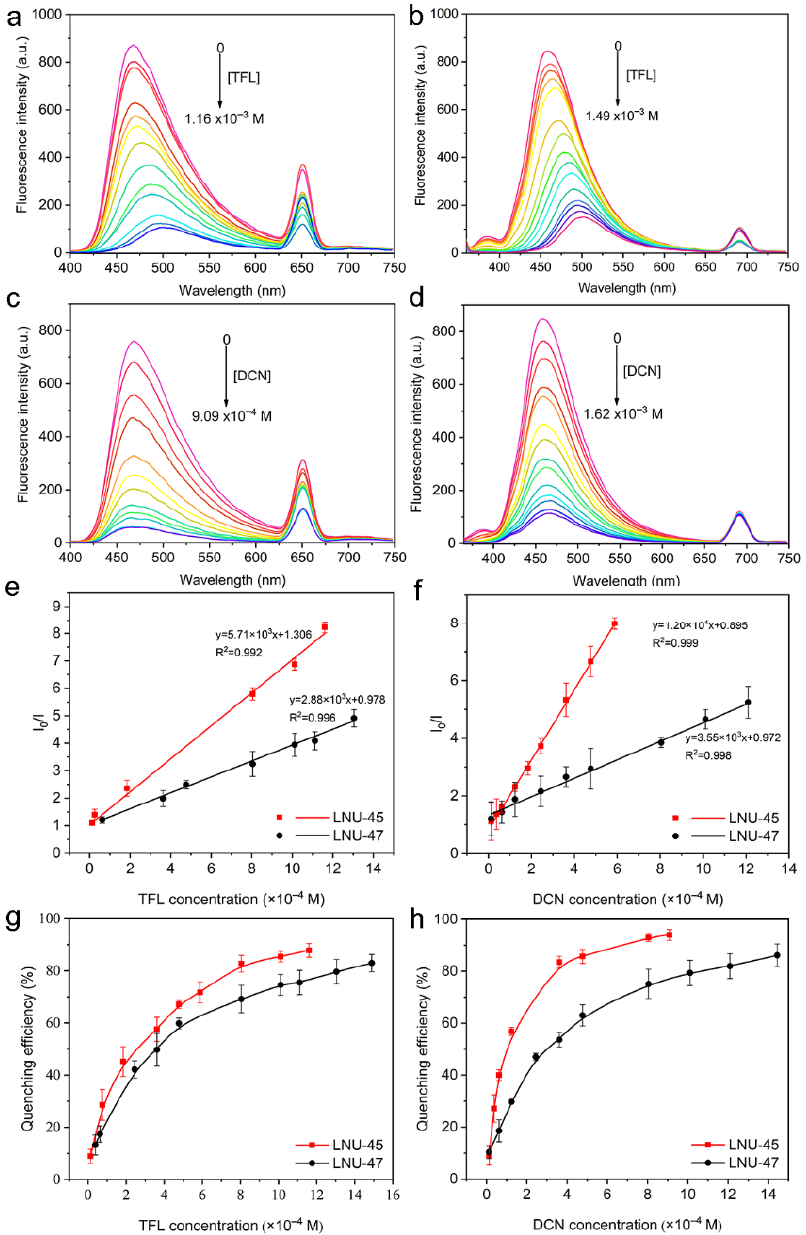
Figure 5. Fluorescence emission spectra of LNU-45 ( a ) and LNU-47 ( b ) in THF upon the addition of trifluralin in different amounts. Fluorescence emission spectra of LNU-45 ( c ) and LNU-47 ( d ) in THF upon the addition of dicloran in different amounts. Stern–Volmer plots of LNU-45 ( e ) and LNU-47 ( f ) quenched by trifluralin and dicloran, respectively. Quenching efficiency of LNU-45 ( g ) and LNU-47 ( h ) for pesticides with different concentrations.